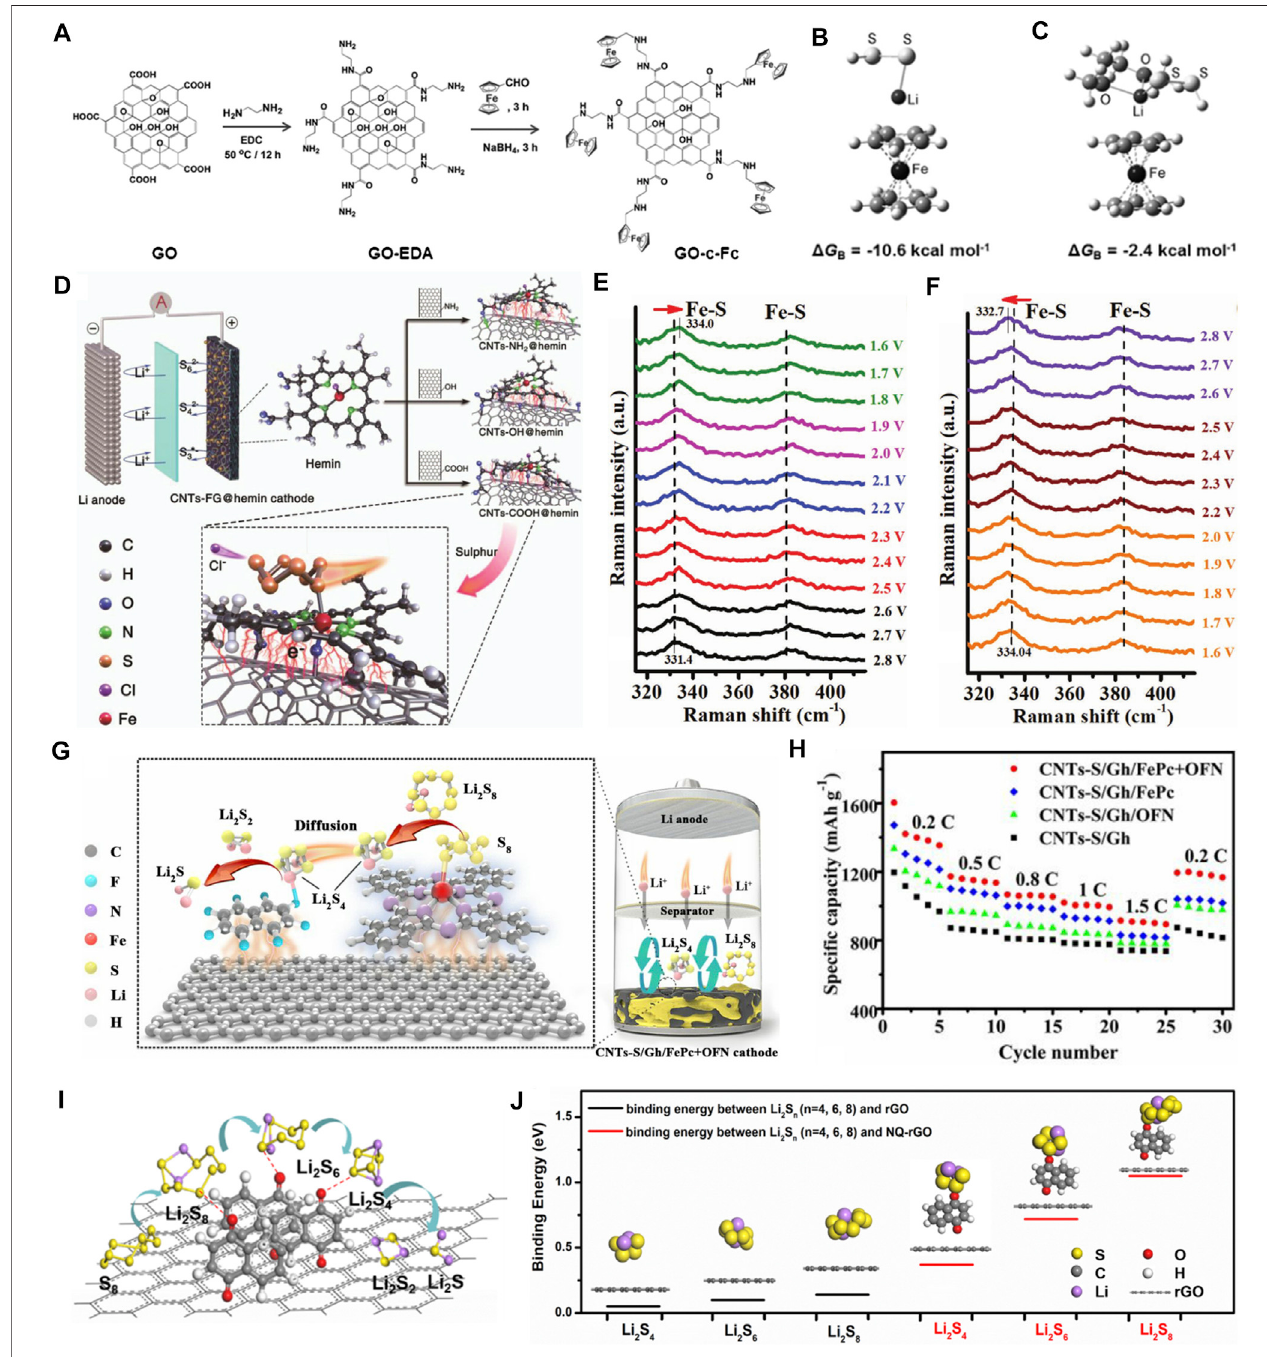
FIGURE2| Evolutionsofsulfurconversionbyorganicelectrocatalyticadditives. (A) TheschematicsynthesisofferrocenefunctionalizedGO-c-Fc. (B,C) Optimized con fi gurationsofGO-c-FcwithLiPSs. (A – C) FigurereproducedfromthedatainMietal.(2016). (D) TheLi − SbatterybasedonvariousCNTs-FG@hemincathodes(FG (cid:2) NH 2 ,OH,COOH)andtheadsorptionmechanismofLiPSsonCNTs-COOH@hemin. (E, F) In-situ RamanspectraofCNTs-COOH@hemin cathodeduringthedischarge and charge processes. (D – F) Figure reproduced from the data in Ding et al. (2020). (G) The schematic mechanisms of Gh/FePc+OFN for LiPS adsorption/ conversion. (H) The comparison of rate performances of CNTs-S/Gh, CNTs-S/Gh/OFN, CNTs-S/Gh/FePc, and CNTs-S/Gh/FePc+OFN cathodes. (G, H) Figure reproduced from the data in Zhou S. et al. (2020). (I) A diagram of NQ-rGO composite and its catalytic effects on LiPSs. (J) The optimized con fi guration and the binding energy of Li 2 S 4 , Li 2 S 6 , and Li 2 S 8 on rGO and NQ-rGO, respectively. (I, J) Figure reproduced from the data in Sun W. et al. (2020).